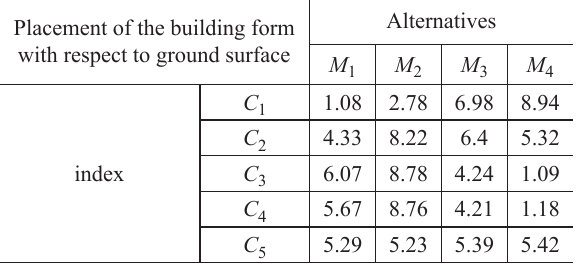
Table 21. Averages of experts’ scores for alternatives of placement of the building form towards ground surface within the major indexes Placement of the building form with respect to ground surface